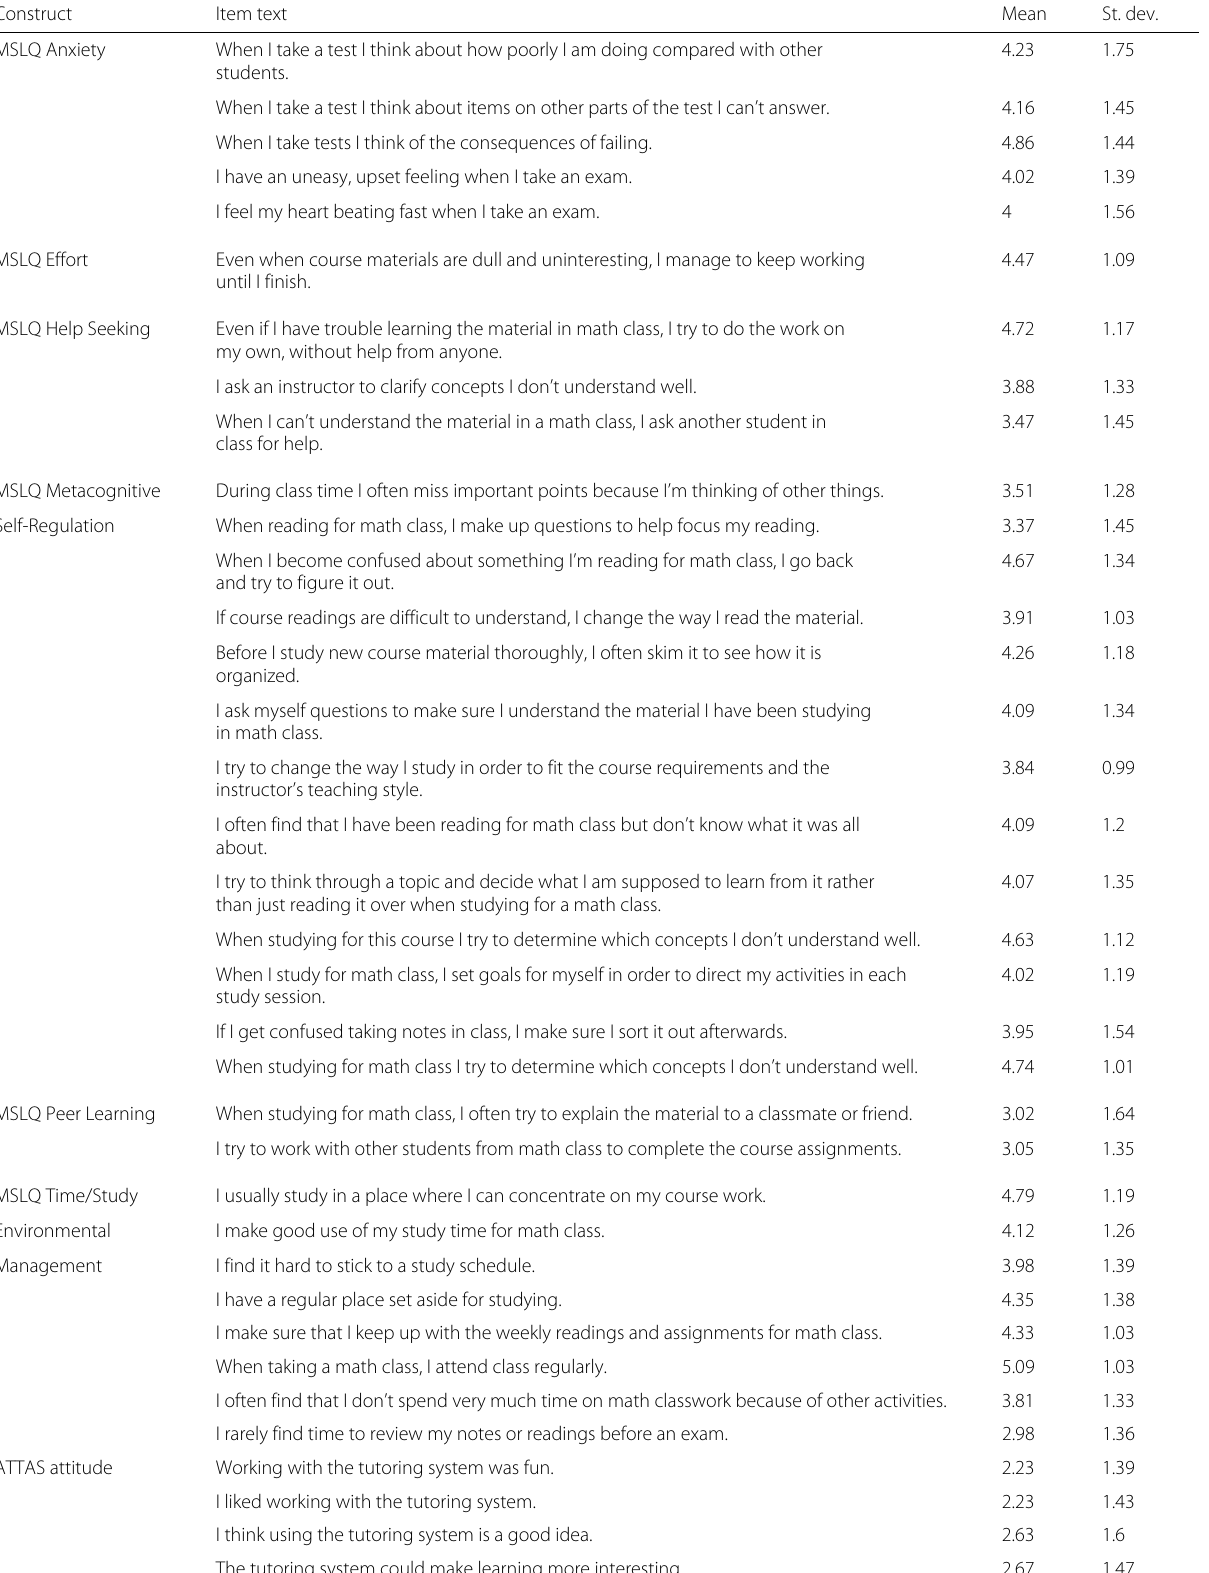
Table 5 Post-survey item means and standard deviations Construct Item